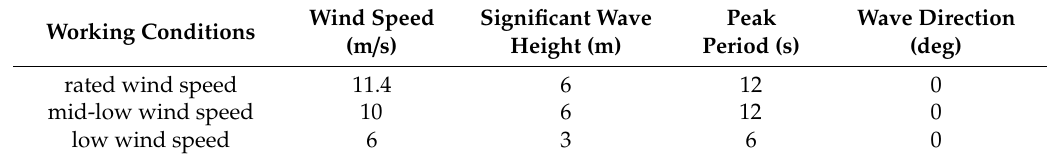
Table 2. Sea state Table 2. Sea state parameters.